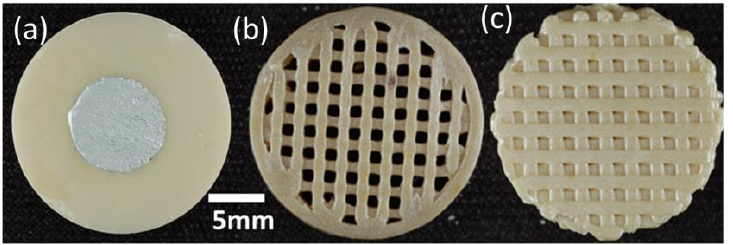
Figure 4. Sintered PZT pellets: ( a ) uniaxially pressed reference sample, ( b ) material extrusion-based (MEX) additive manufactured scaffold structure, and ( c ) 3D printed offset structure.